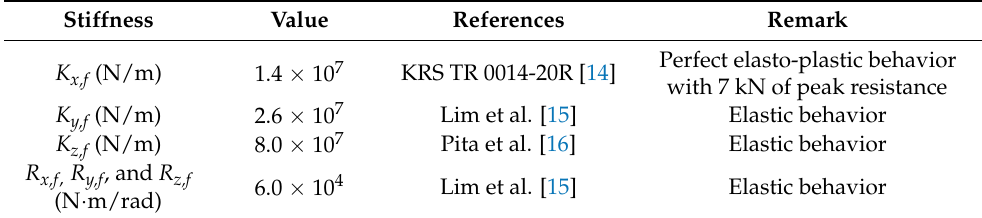
Table 2. Rail fastener properties.